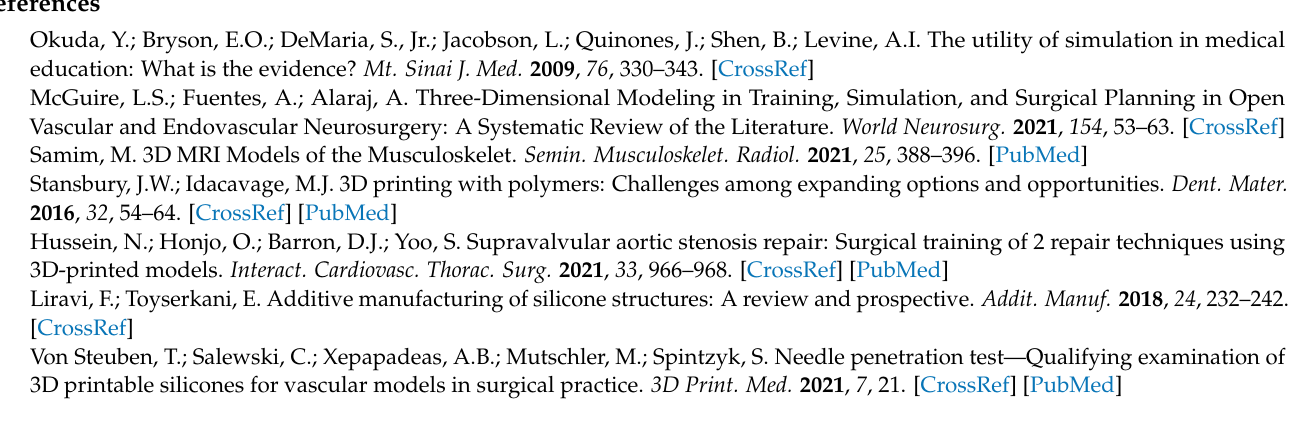
Figure A1. Flow chart of the data evaluation from the test conduction to the comparison of the materials and methods.